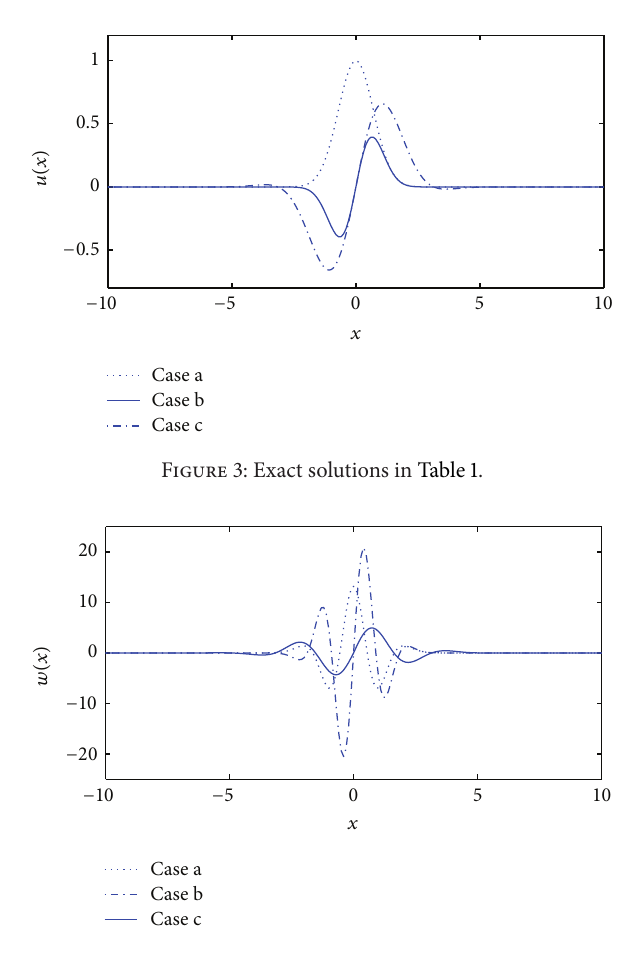
Figure 4: Applied loading conditions corresponding to the exact solution in Table 1.